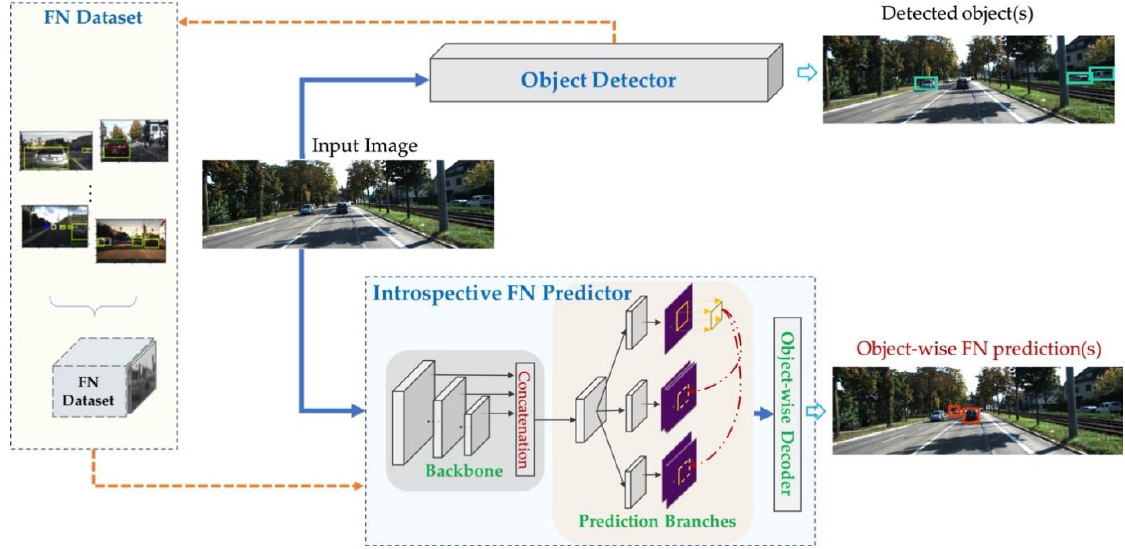
Figure 4. The introspective FN prediction framework proposed in this work. The yellow dotted lines refer to the generation of the FN dataset and its use in the training process, and the blue solid lines refer to the inference process of both object detections and online FN predictions.